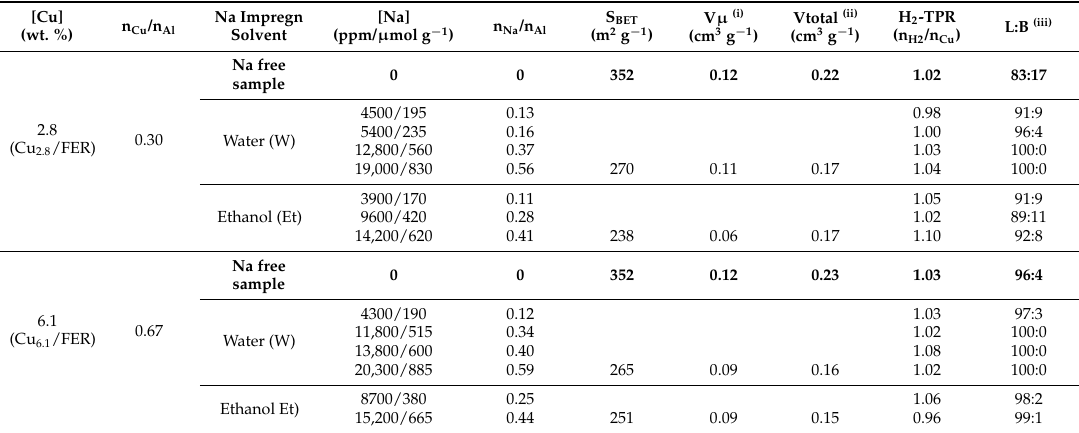
Table 1. Catalysts